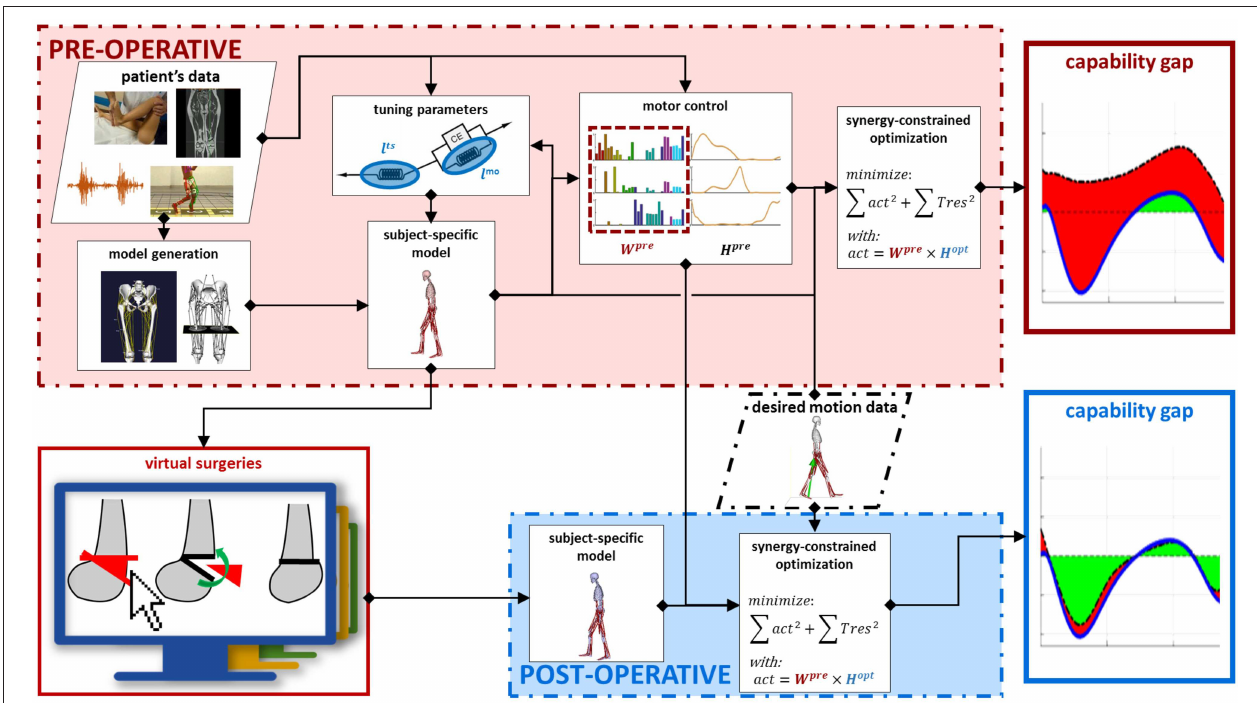
FIGURE 1 | Framework description. Data collected on the patient in the pre-operative phase are used as input to generate a pre-operative model with personalized musculoskeletal geometry and muscle parameters. Next, the motor control of the patient is modeled, using synergy decomposition analysis, based on pre-operative EMG and gait analysis data. Performing virtual surgeries on the pre-operative model generates a post-operative model. This takes into account the changes in the musculoskeletal parameters induced by the performed surgery. The motor control, on the other hand, is not affected by the surgery and the same motor control model computed in the pre-operative condition is used also for the post-operative condition. The gait performance of the patient can be computed in both the pre- and simulated post-operative conditions. In both cases, a synergy constrained optimization tries to match the joint moments relative to a desired motion while taking into account the constraints imposed by the model and by the motor control. The differences between the moments generated by the model and the desired moments are the capability gap, defining the gait